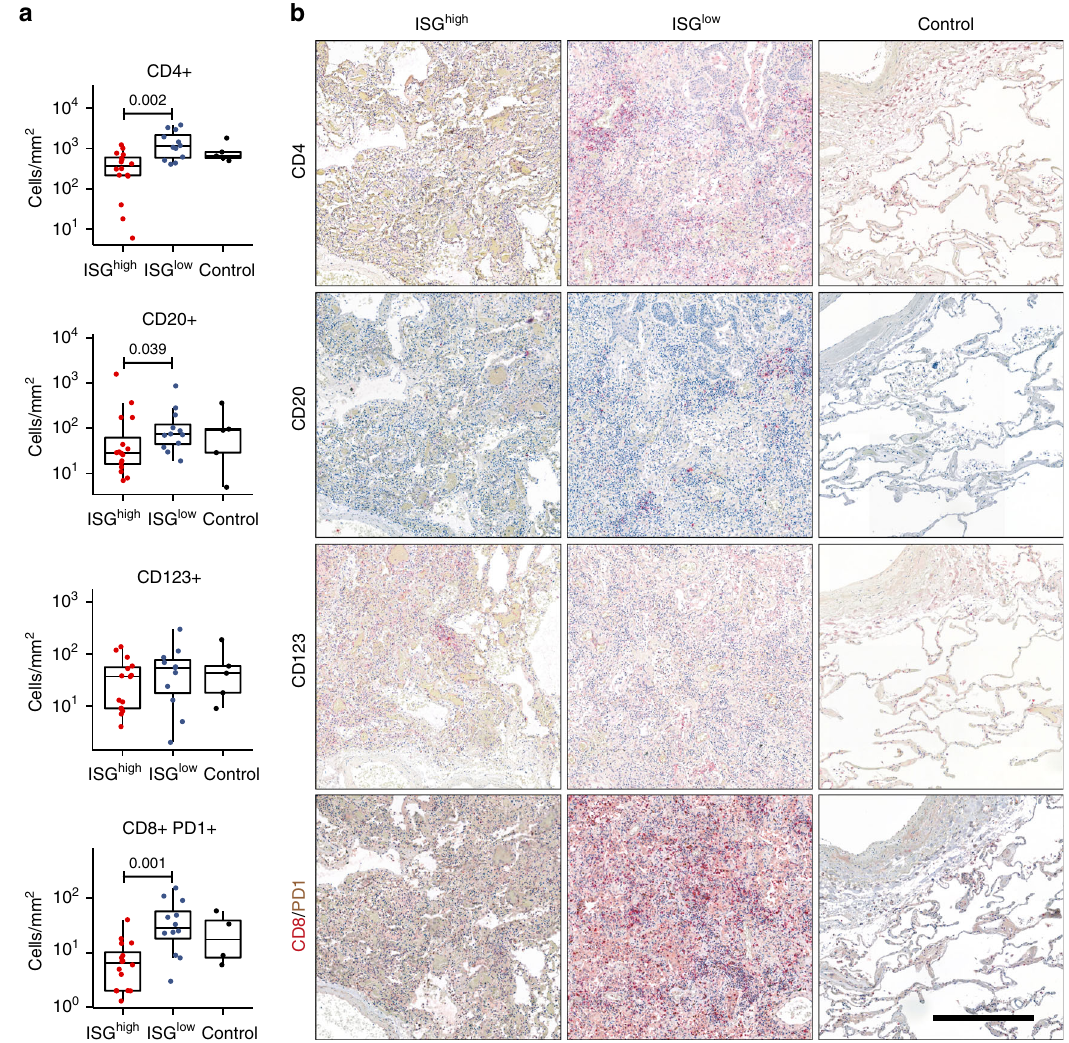
Fig. 4 Immune cell in fi ltrates on COVID-19 lung sections. a Frequencies of immune cells on ISG high and ISG low COVID-19 lung sections and controls ( n = 33 for CD4 and CD20, n = 31 for CD123, n = 32 for CD8/PD1). Box-plots elements indicate the median (center line), upper and lower quartiles (box limits). Whiskers extend to the most extreme value included in 1.5× interquartile range. Groups were compared using a two-sided Wilcoxon rank-sum test. b Representative immunohistochemistry (CD4, CD20, CD123, CD8/PD1) of ISG high and ISG low COVID-19 lungs and controls, size bar 500 μ m. At least two different tissue blocks from different areas of the lungs were evaluated for each case. ISG high samples, red; ISG low samples,